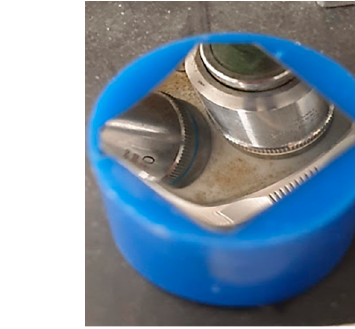
Figure 20. Embedding in resin and grinding/polishing.